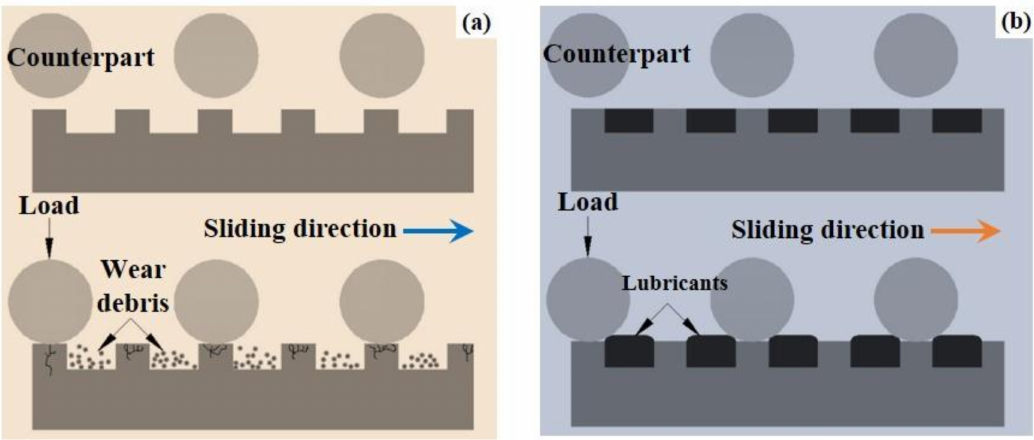
Figure 1. Schematic diagram of active roles of surface texturing in tribological performance: ( a ) continuous lubrication and ( b ) capturing friction